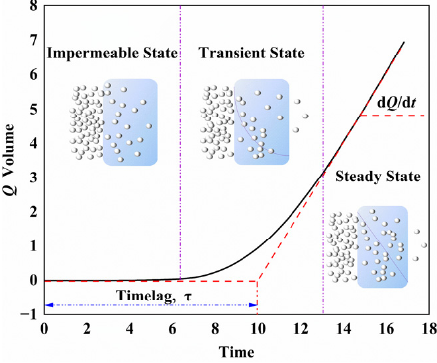
Figure 2. Gas permeate volume curve with time.